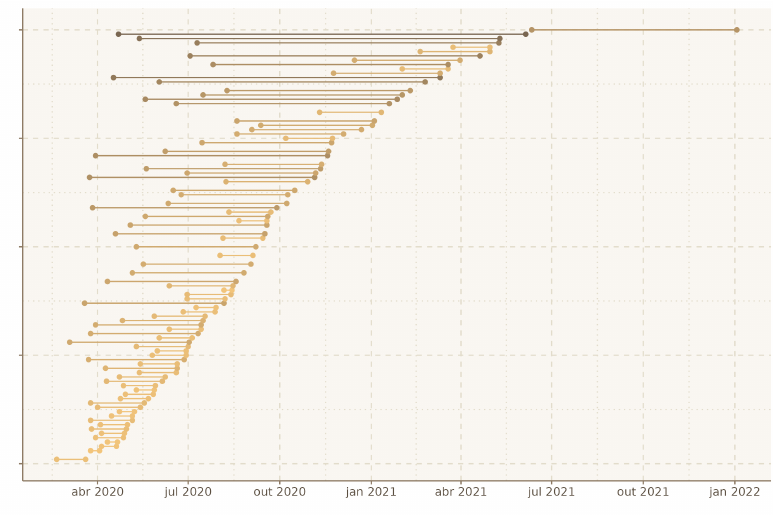
Figure 3. Submission and publication dates.